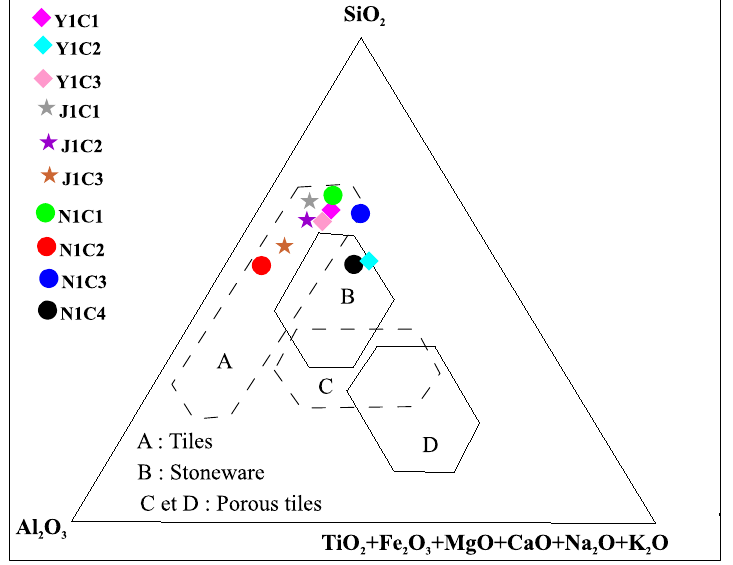
Figure 9. Composition of clay materials of the eastern part of the Douala sub-basin in the diagram of Fiori et al. [35].